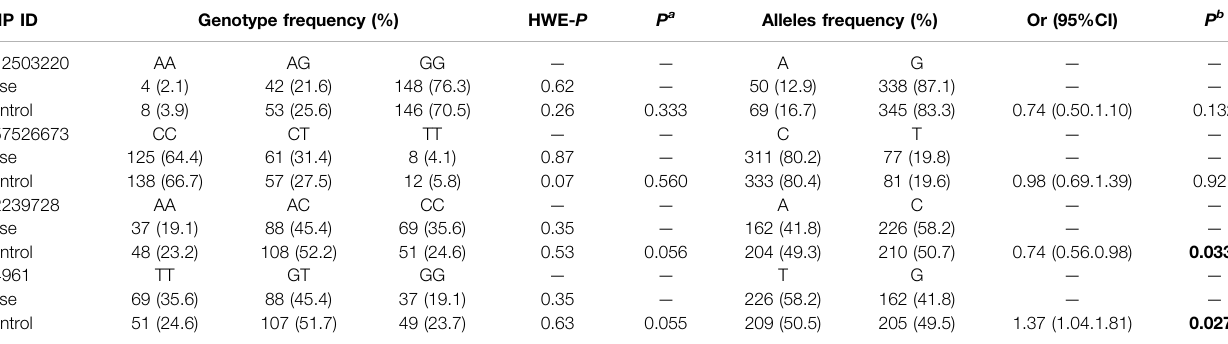
TABLE 6 | Genotypes and allele frequency of ADD1 polymorphism between EH and healthy control patients and their relationship with EH risk in the Han